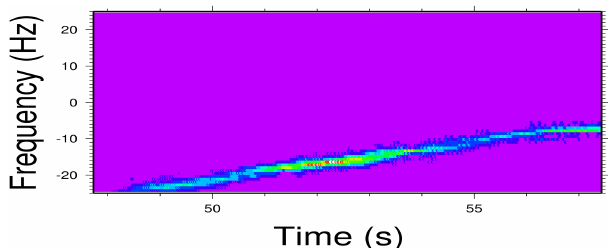
Figure 9. The location in time of the reflected signal is determined cross-correlating the radio-hologram and a template image of the typical reflection signature. In Fig. 2, this identifies as the interest interval the time section shown here. Only this interval is further analysed for the purpose of reflections. All frequency components above − 5Hz are set to noise level, which rejects the direct signal, which was close to 0 frequency. After inverse Fourier transform of the filtered hologram, a phase lock loop (PLL) can track the signal identified as the reflection, obtaining f R (t) .